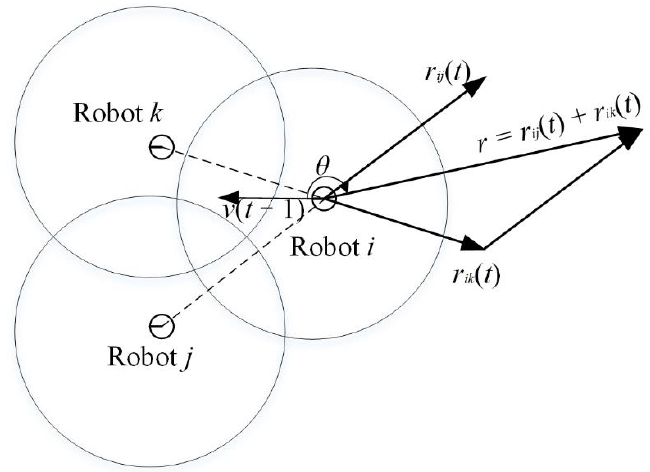
Figure 7. Illustration of the integrated virtual repulsive force for robot i .